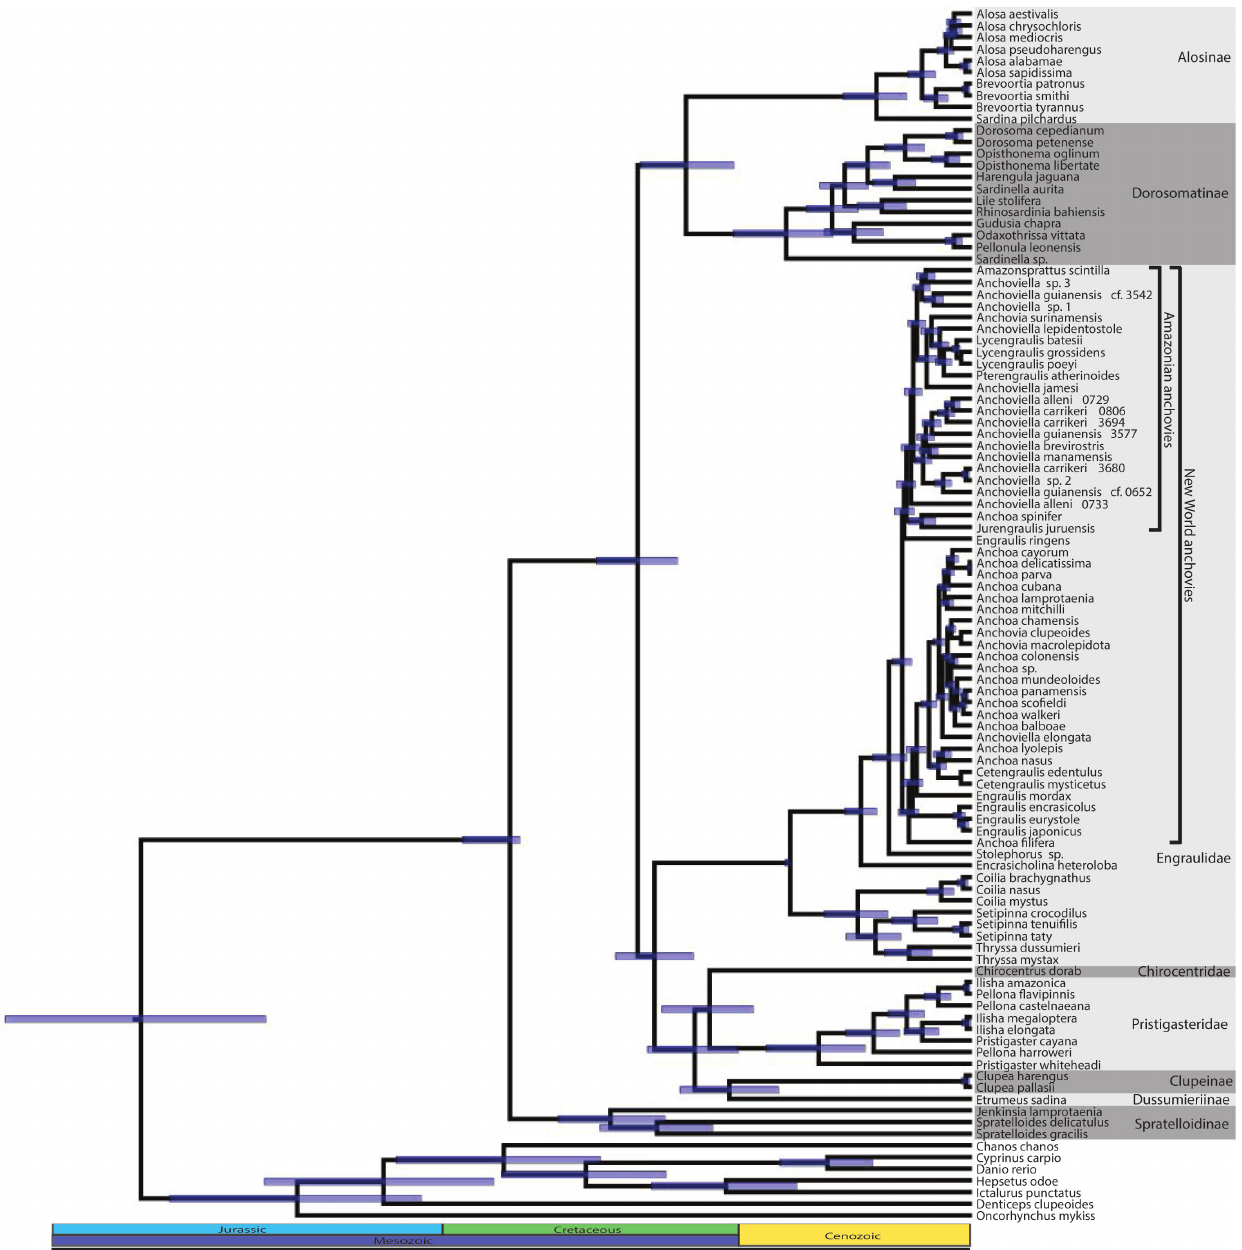
Fig. 3. Time-calibrated clupeoid phylogeny resulting from Bayesian analysis of the nDNA dataset in BEAST v.2.4.5. Time, in millions of years, is shown along the x-axis. Node bars show the 95% highest posterior density interval of divergence time